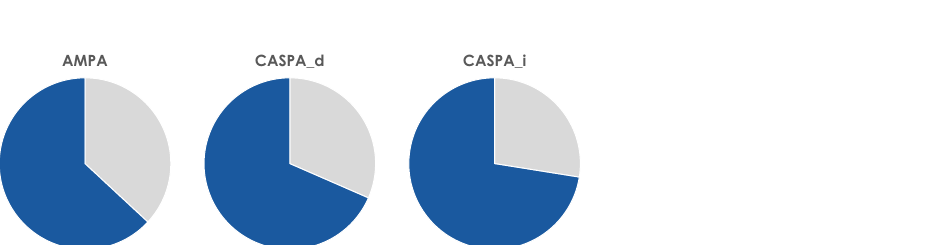
Figure 3. Sensitivity of SDA-M-based error prediction in assembly. Blue areas indicate the percentage of actual errors that could be correctly detected with AMPA (63%), CASPA d (68%), and CASPA i (72%) based on individual SDA-M data in two assembly scenarios.